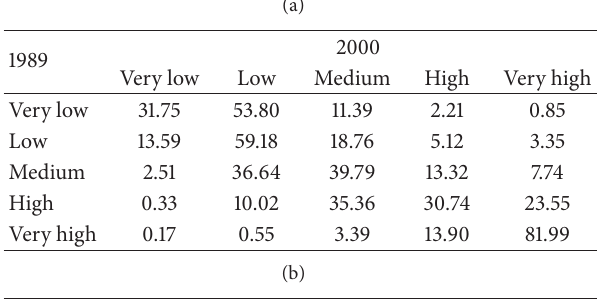
Table3:TheLSTtransitionmatrixforthechangesbetweendifferent LST classes for each year.